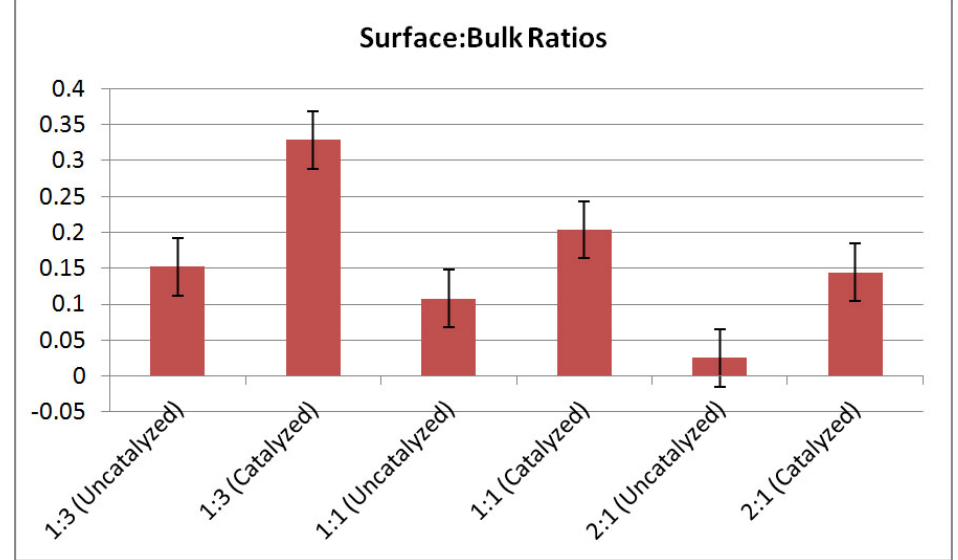
catalyzed LiBH 3